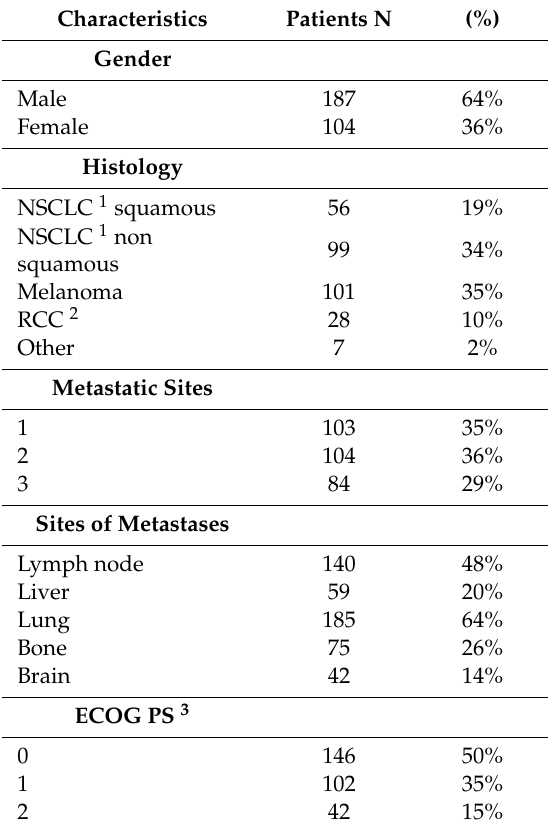
Table 1. Baseline characteristics and